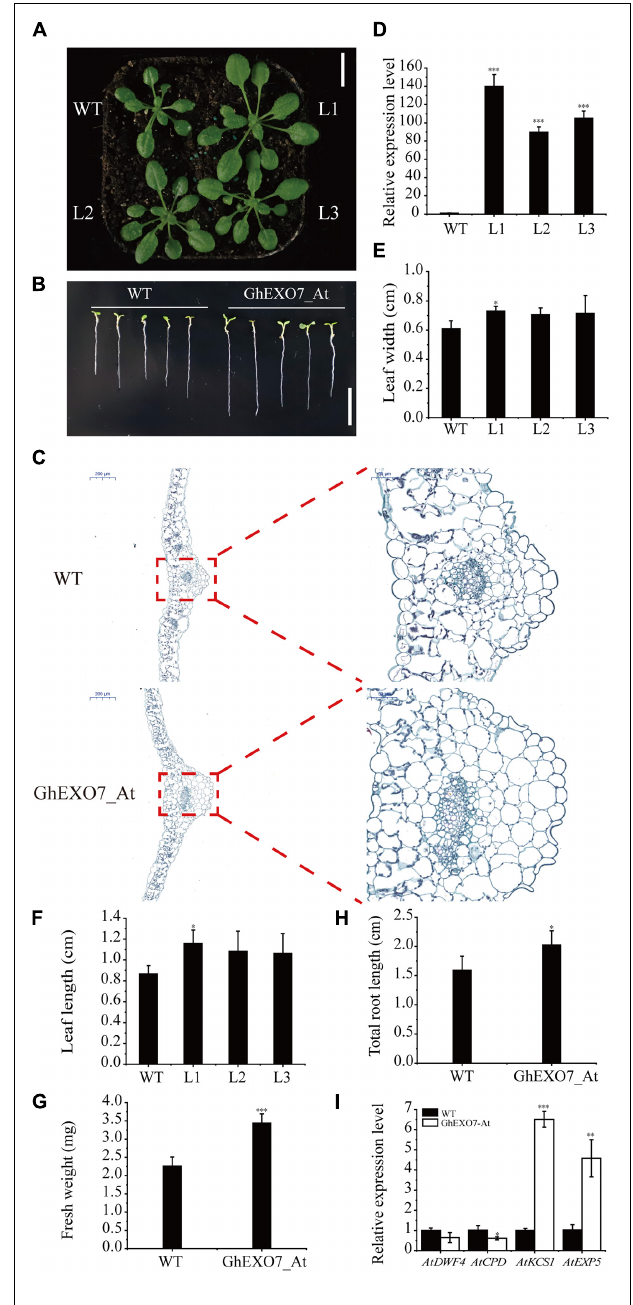
FIGURE 7 | Phenotypes of plants from Arabidopsis lines overexpressing GhEXO7_At . (A) Phenotypic comparison of three GhEXO7_At lines and Col-0 (WT). Scale bars = 1 cm. (B) The root phenotypes of WT and GhEXO7_At -OE plants grown 14 days in the 1/2 MS. Scale bars = 1 cm. (C) Comparison of cells size from the fifth leaf of GhEXO7_At -OE and WT. (D) Relative GhEXO7_At expression levels in Col-0 and GhEXO7_At transgenic plants. Width (E) and length (F) of the fifth rosette leaf in WT and GhEXO7_At overexpression plants, Student’s t -test: ∗ p < 0.05. Comparison of plant fresh weight (G) and total root length (H) of GhEXO7_At -OE and WT. (I) Relative expression levels of BR-repressed genes ( CPD and DWF4 ) and BR-induced genes ( EXP5 and KCS1 ) in Col-0 and the GhEXO7_At transgenic plants. Significant differences in expression were determined by Student’s t -test: ∗ p < 0.05, ∗∗ p < 0.01, ∗∗∗ p <